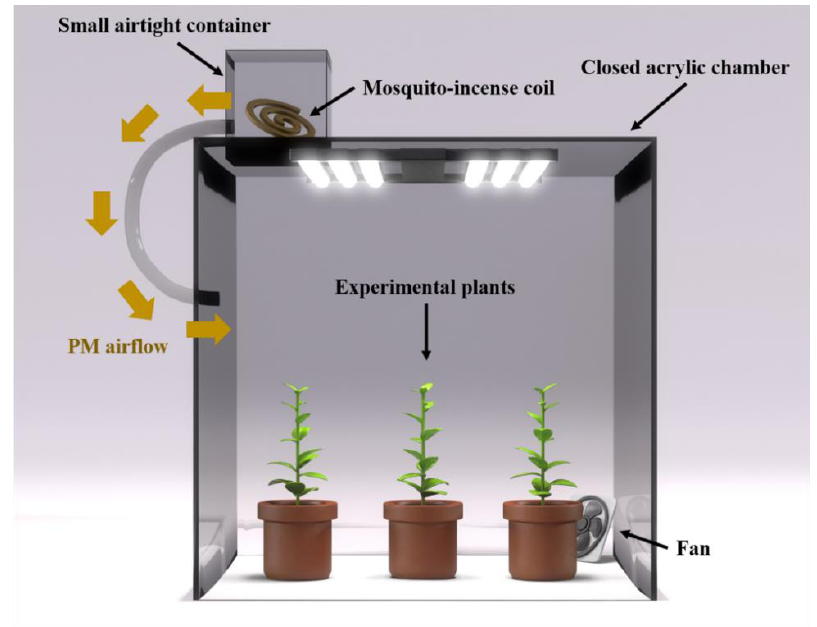
Figure 1. The design schematic of the closed acrylic chamber used for the particle matter (PM) reduction tests.